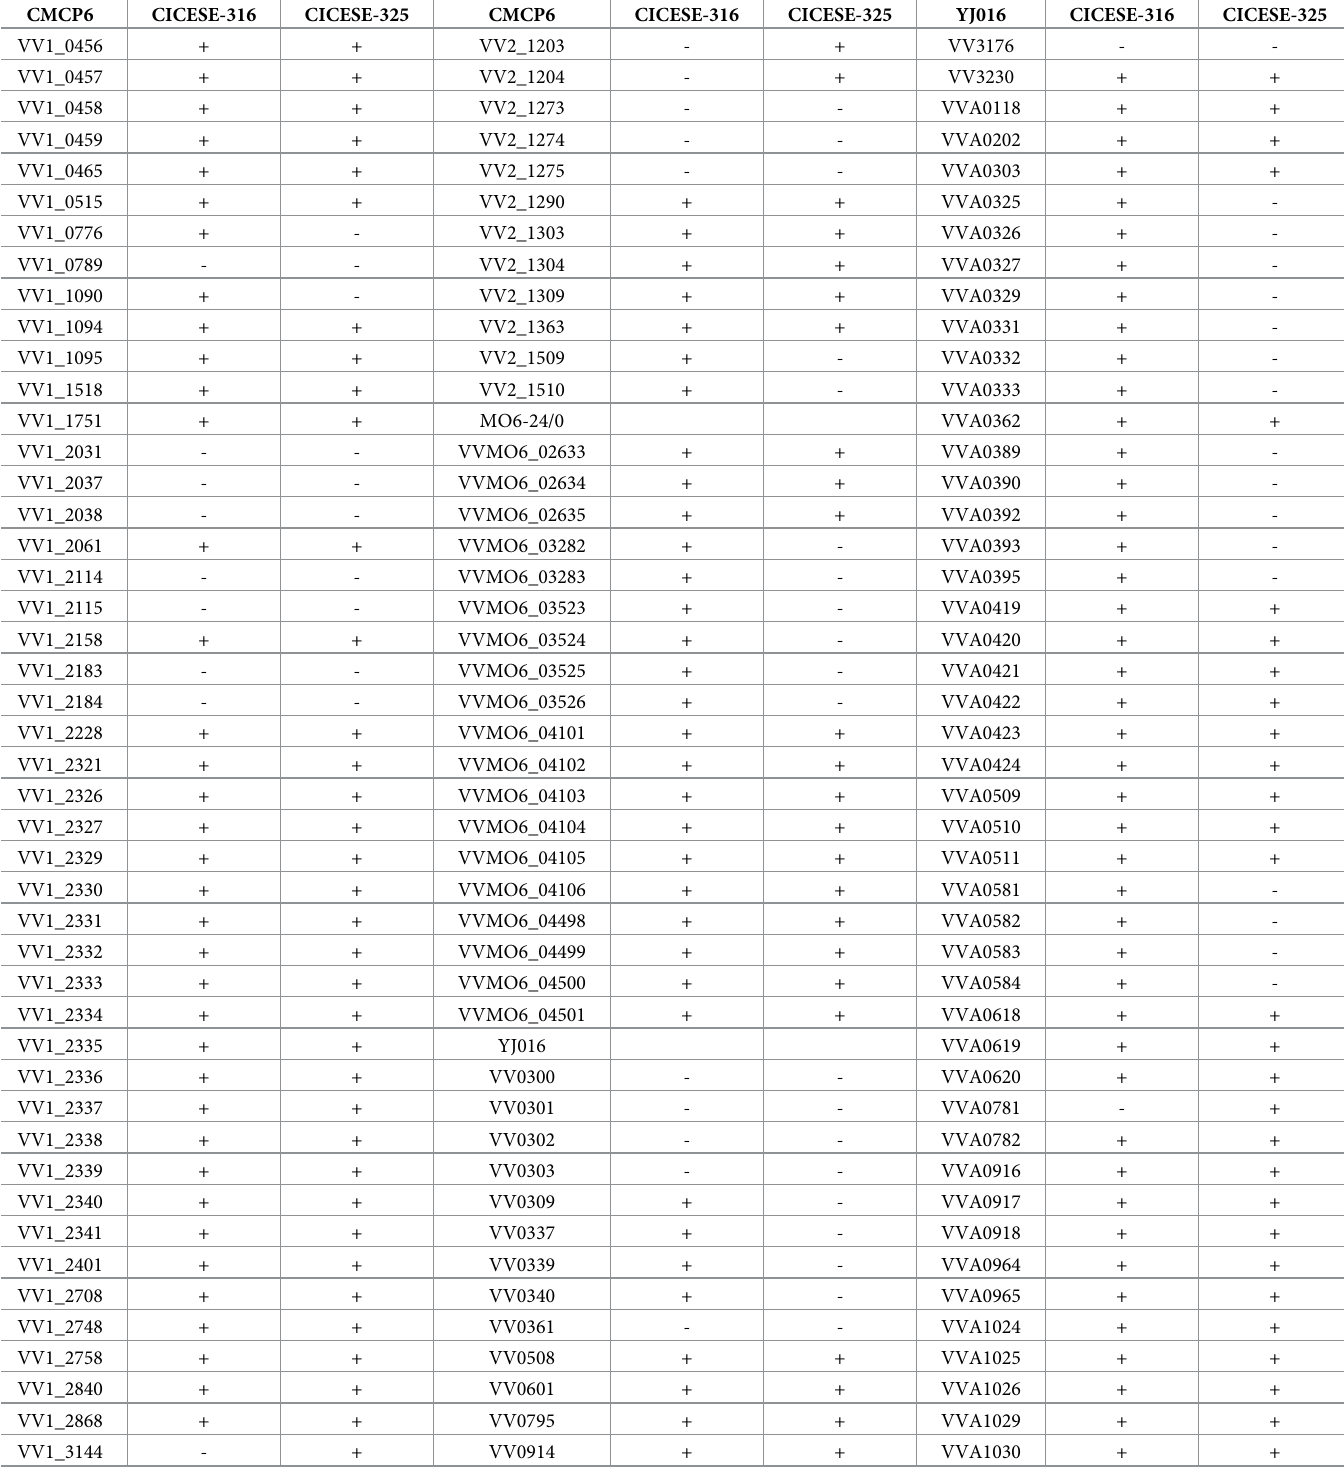
Table 2. List of pathogenicity C-genotype genes of V . vulnificus reported for pathogenic strains, CMCP6, MO6-24/O and YJ016, after Gulig et al. [36], Chen et al. [26] and Morrison et al. [23].